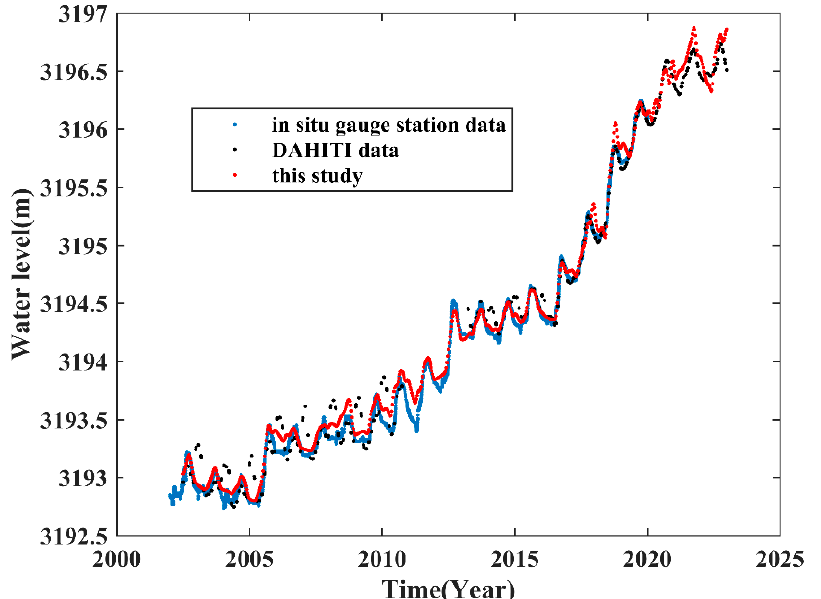
Figure 12. Comparison of the fi nal results of this paper with the hydrological gauge data from the Xiashe station and DAHITI.